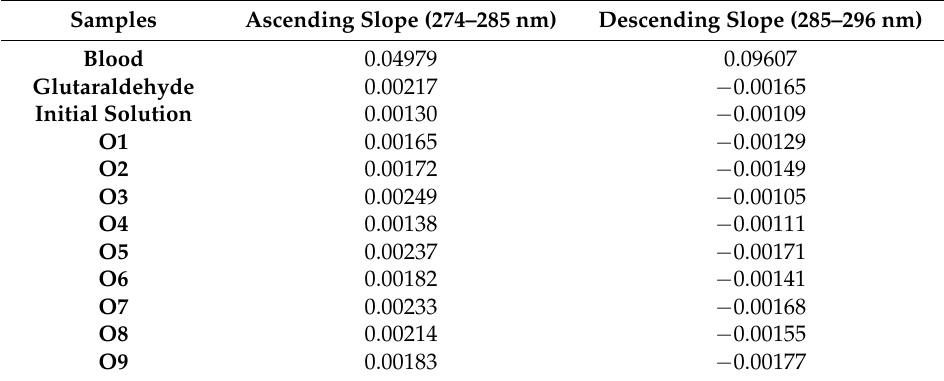
Table 2. Average ascending (274–285 nm) and descending slopes (285–296 nm) calculated for each